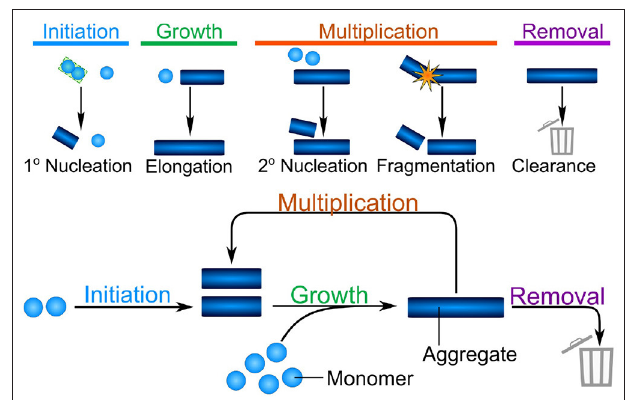
FIGURE 1 | The different classes of processes combine into the fundamental reaction network of aggregation. Initiation is the formation of the first aggregates, without the involvement of existing aggregates. Growth is the increase in size of existing aggregates by addition of further protein subunits. Multiplication denotes any process by which existing aggregates trigger the formation of new aggregates, shown here schematically are fibril surface-catalyzed secondary nucleation and fragmentation. Finally, in vivo , aggregates can be removed by a number of clearance or degradation pathways. These fundamental classes of processes form the reaction network of aggregation, with growth and multiplication coupling together in a positive feedback loop, that gives rise to the characteristic exponential growth in aggregate mass that many systems